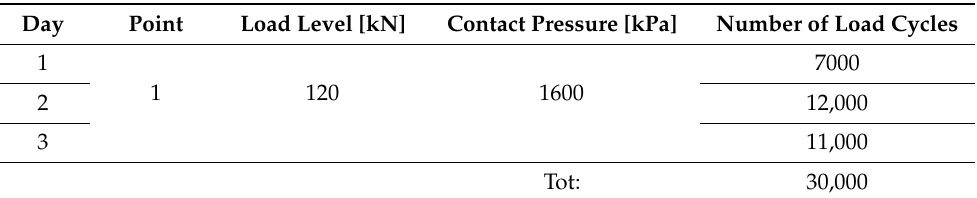
Table 5. First trial section FastFWD load levels and load cycles.